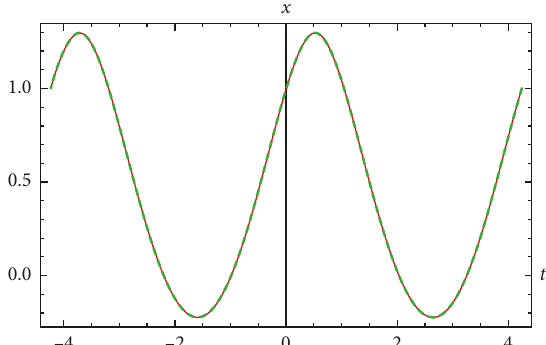
Figure 6: Comparison between the approximate analytical solution and the numerical solution for Example